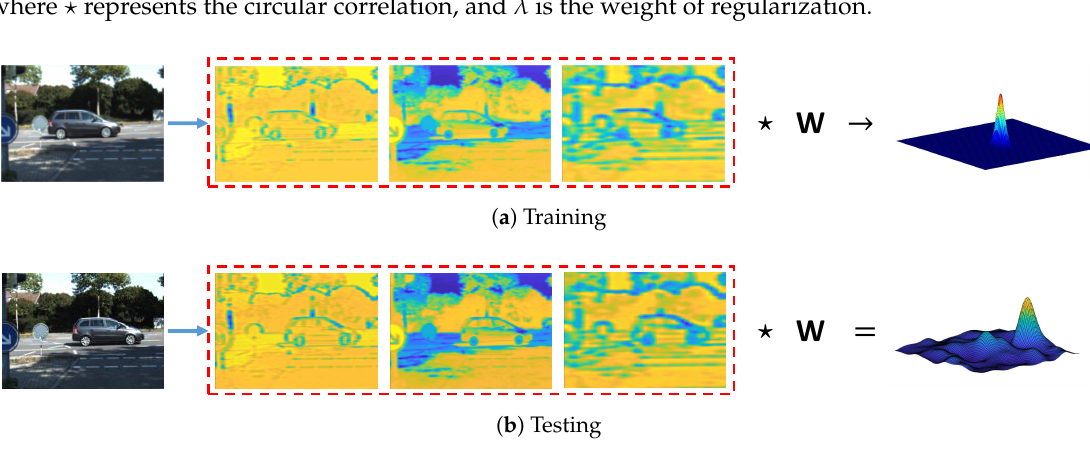
Figure 3. The figure illustrates the training ( a ) and testing ( b ) process of CCF. Three of the compressed CNN feature channels are displayed in the middle. In the training phase, correlation filter weight W is obtained by solving the ridge regression problem in Equation (3), and the desired output is a Gaussian distribution. In the testing phase, the response map is calculated using Equation